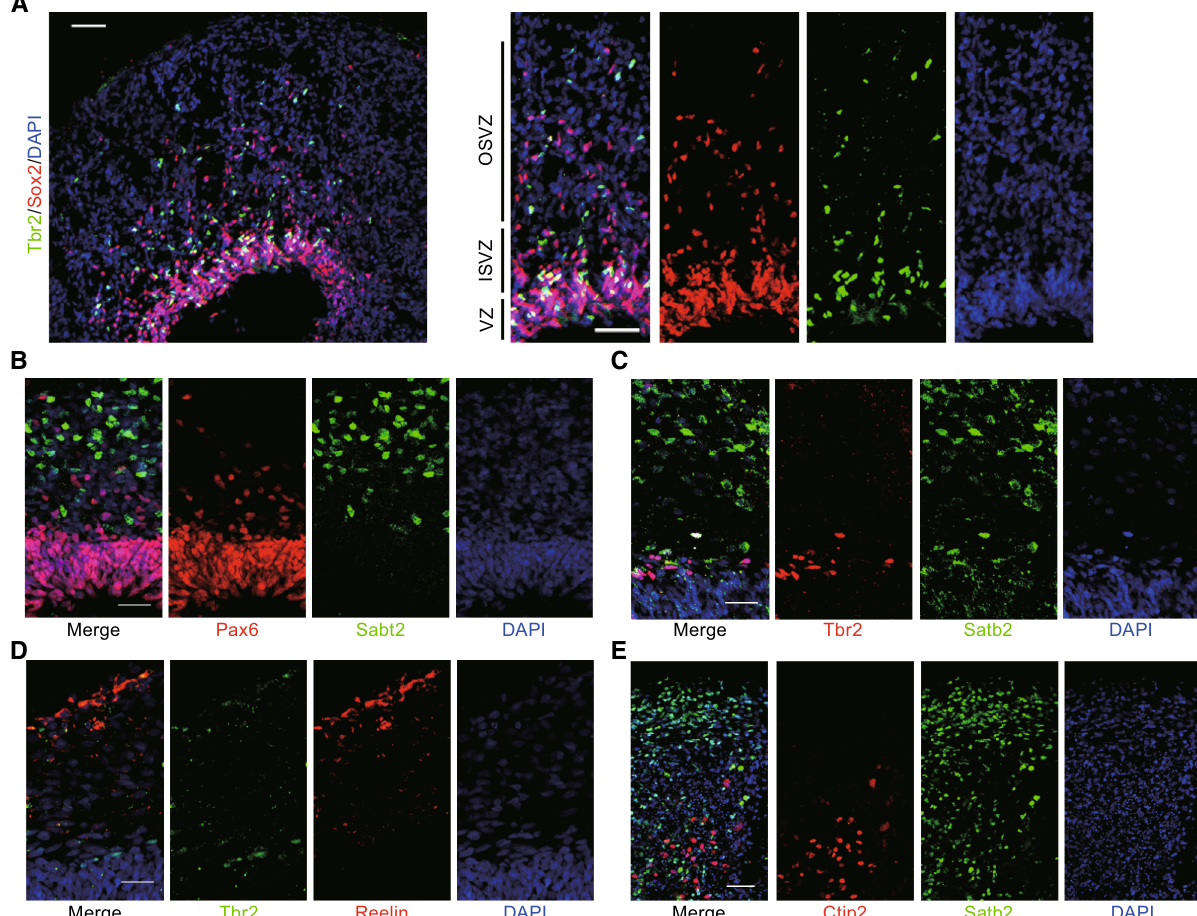
Figure 2. Cortical spatial lamination in 3D organoid culture. (A) Cryosections of organoids were immunostained for progenitor markers on day 65. (B – E) Immunostaining results of progenitor and pyramidal markers in organoids on day 65 (B – D) and day 90 (E). Scale bars: 50 μ m in (A –